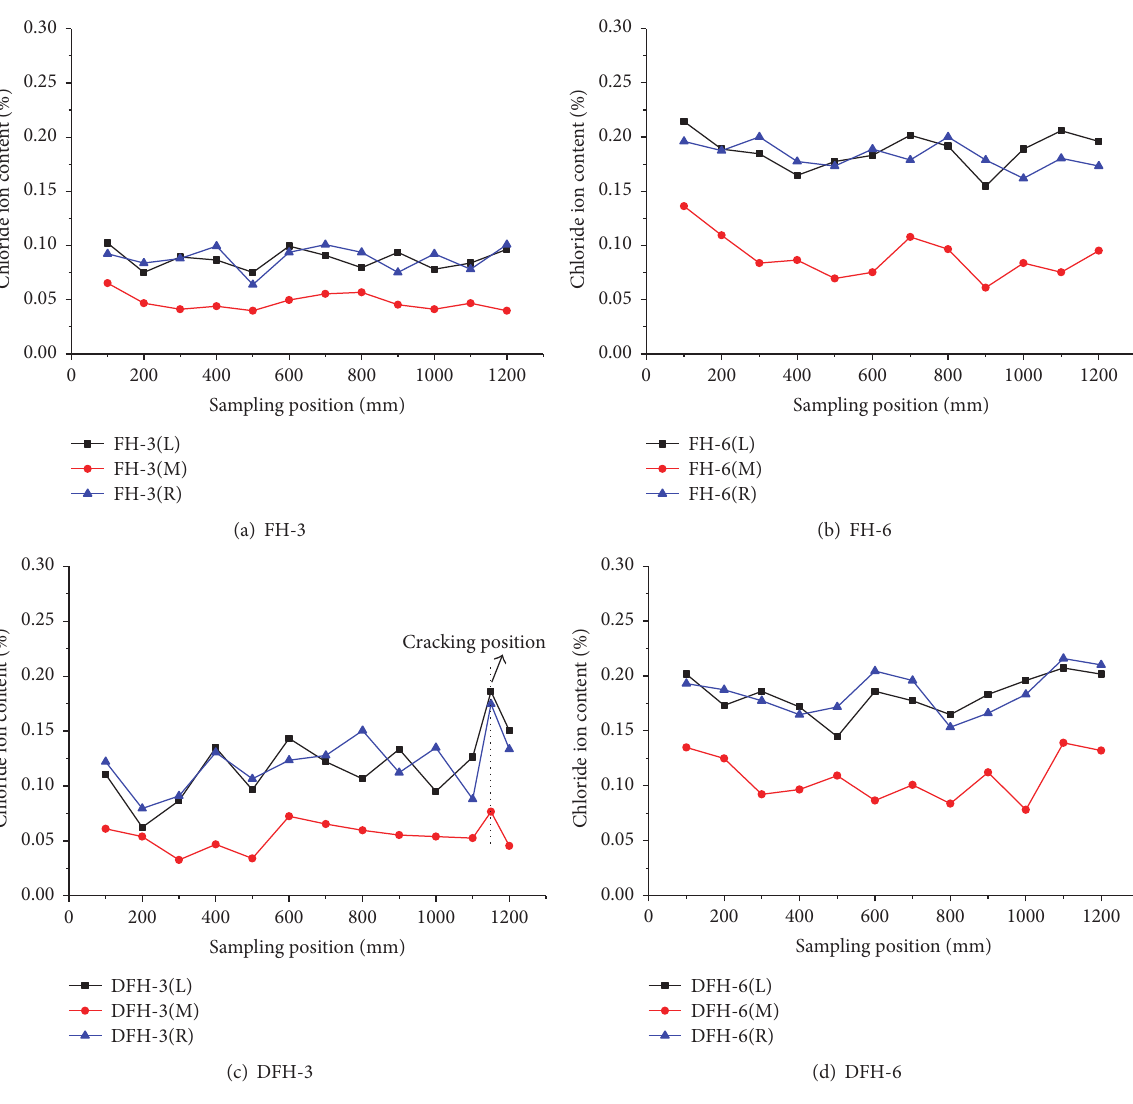
Figure 9: Chloride profiles of the